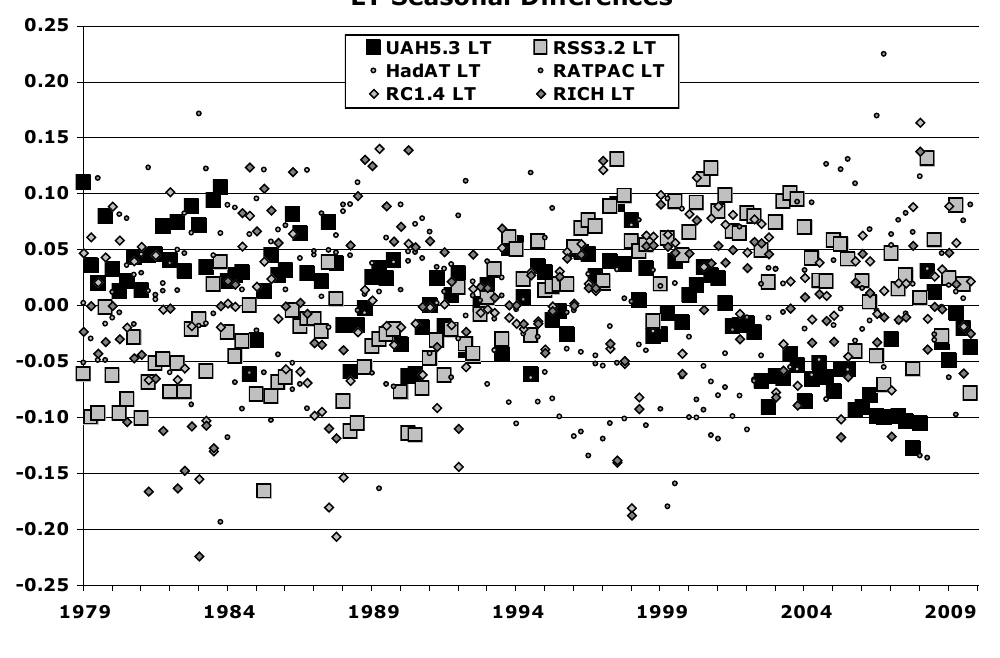
Figure 2. Seasonal anomaly differences of each dataset from the six-dataset mean in Figure 1 (includes RATPAC).